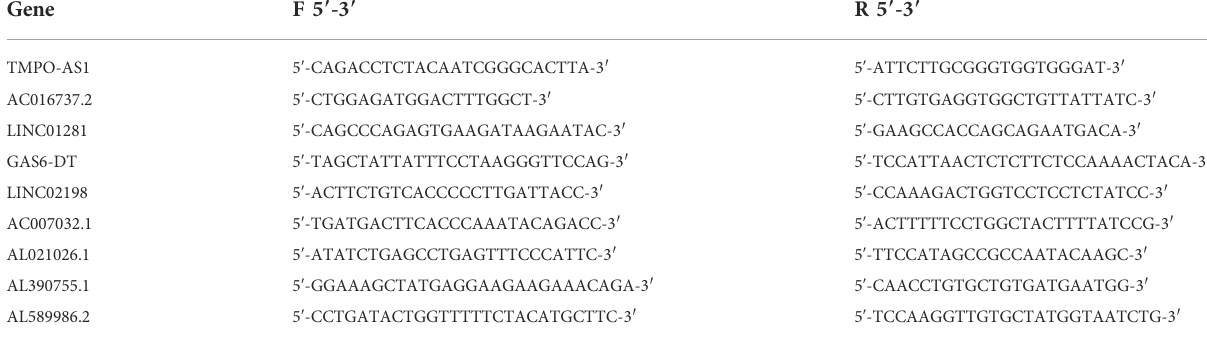
TABLE 3 The PCR primer